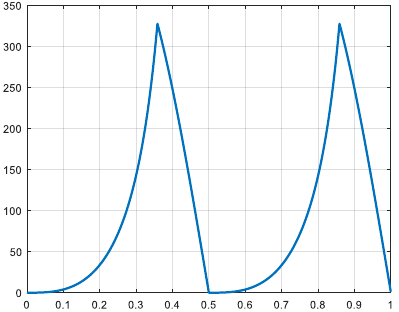
Figure 15. Load torque transmitted to the rotor [Nm].